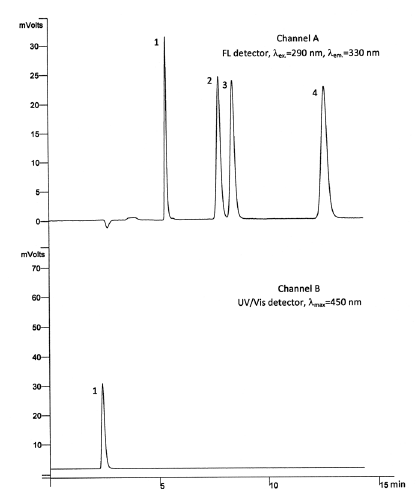
Fig. 2: Typical chromatogram of L. perennis Channel A: 1= a -tocopherol (2.16 μg mL -1 ). Channel B: 1= b -carotene (2.20 μg mL -1 ).